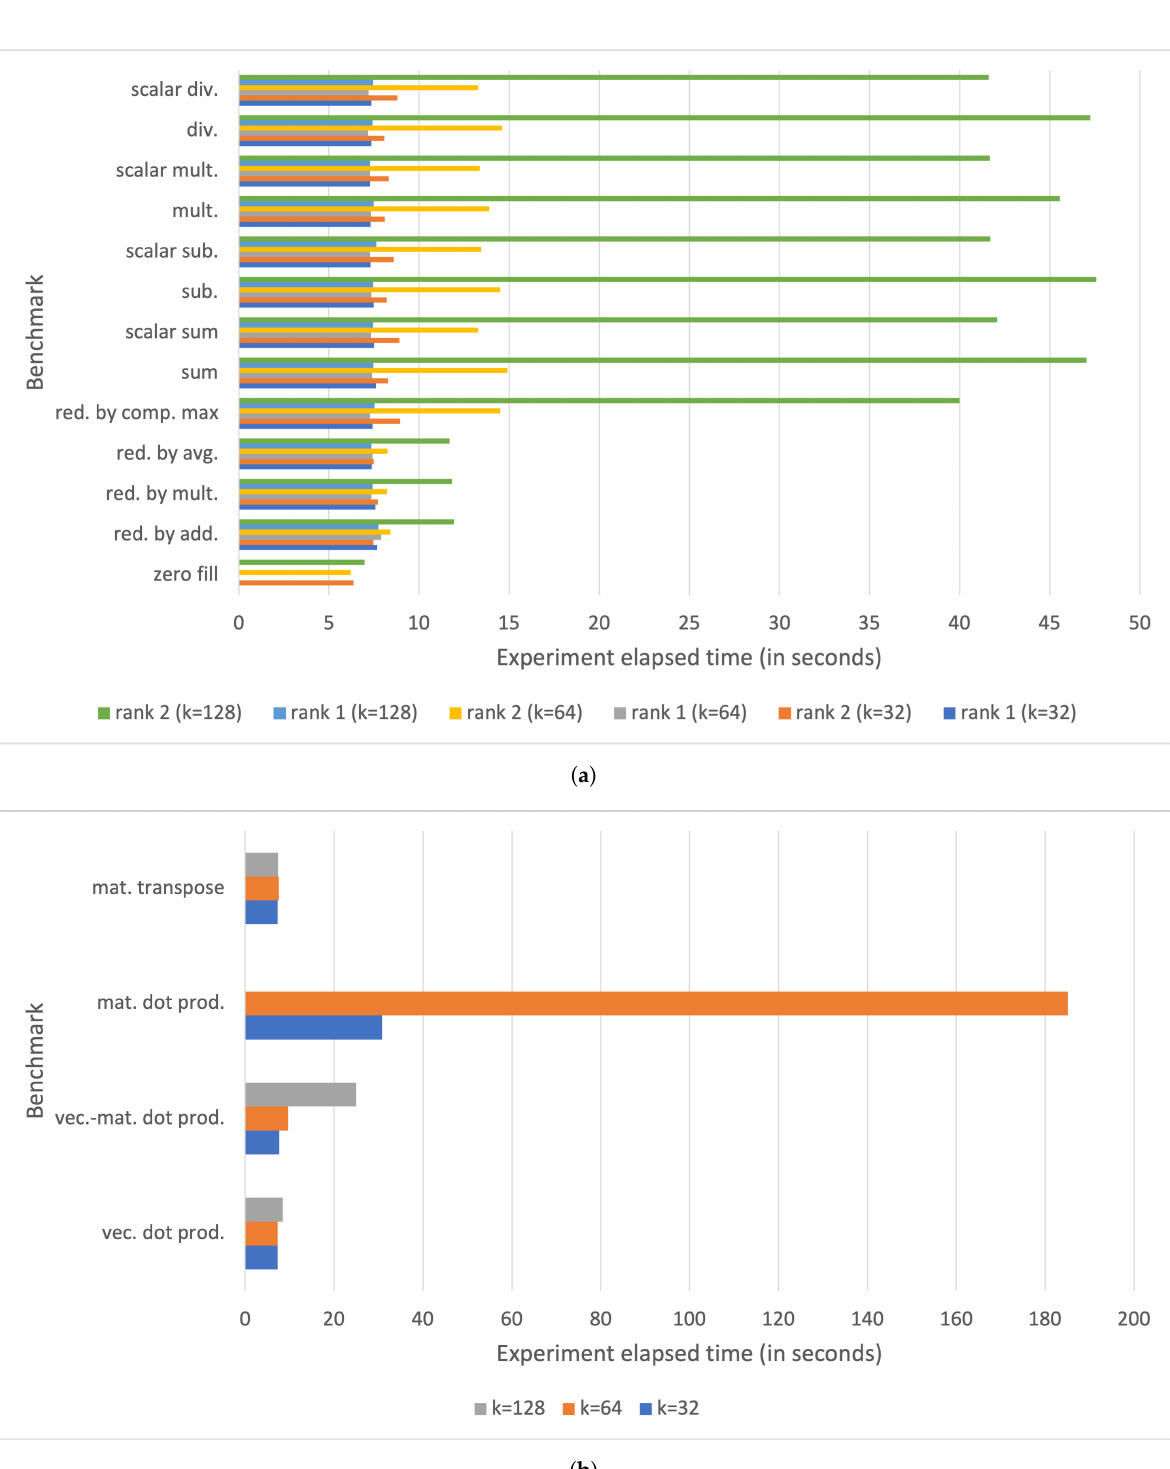
Figure 11. Elapsed time for running all the measurements on a Raspberry Pi III B+ for ( a ) tensor operation benchmarks, and ( b ) vector and matrix operation